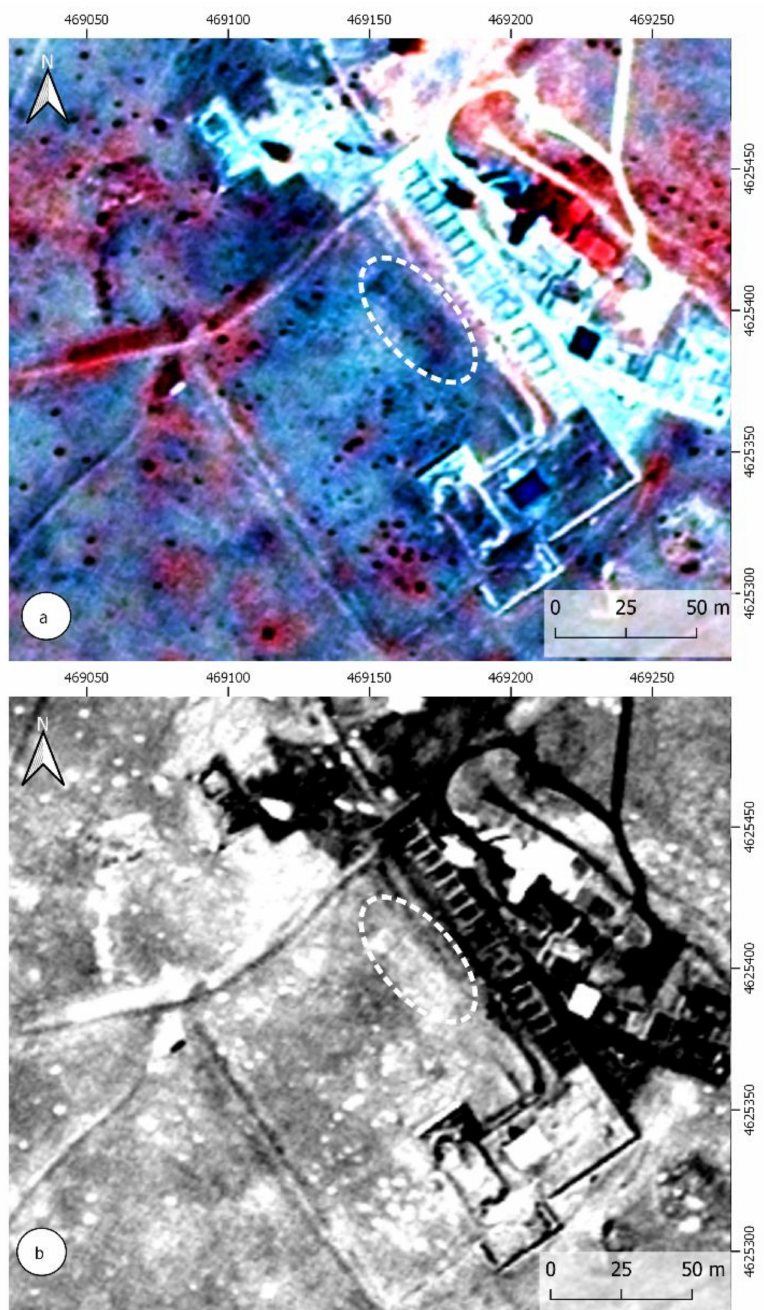
Figure 8. ( a ) TripleSat image from 18 June 2016, bands IR, R, G; ( b ) First component analysis principal component applied to image TripleSat of 18 June